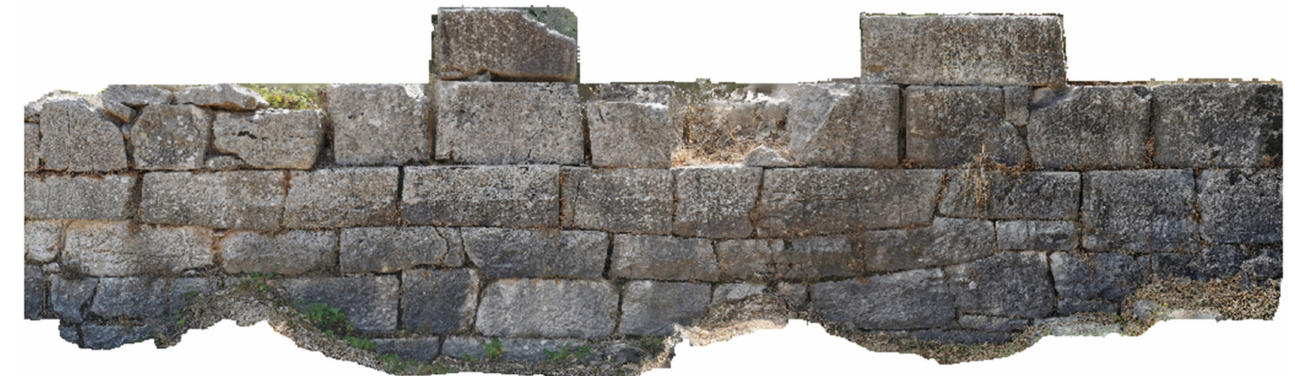
Figure 10. Orthoimage mosaic, cella wall remains at the Temple of Athena and Zeus Sotiros.